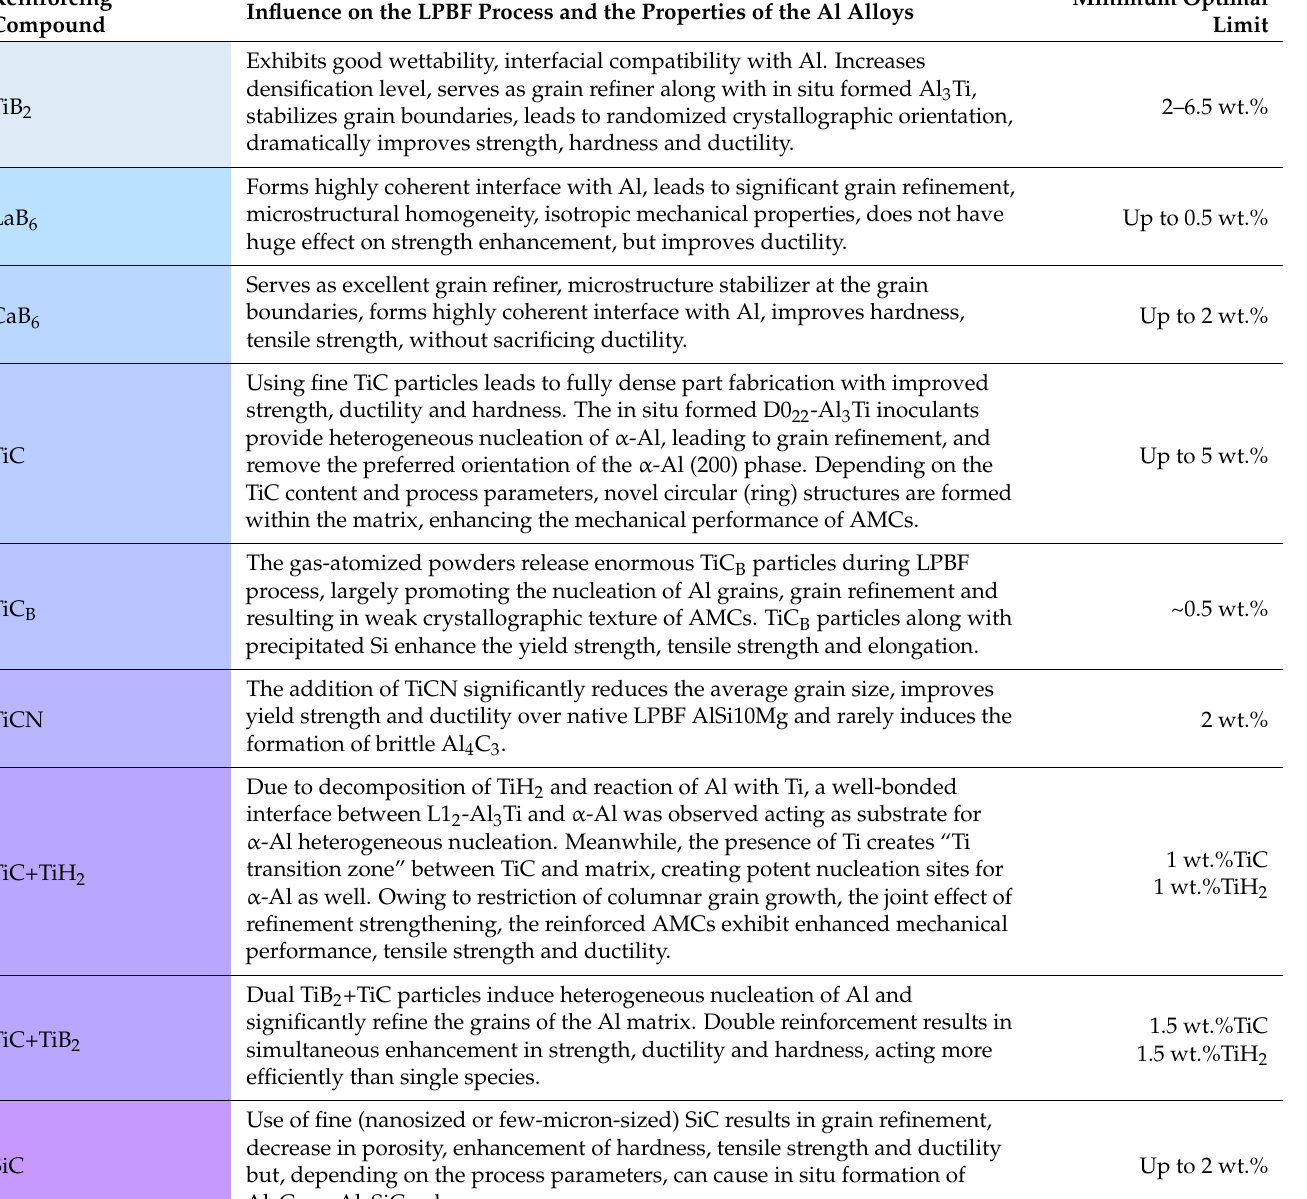
Table 4. The effect of reinforcing compounds on the fabrication and properties of AMCs and their optimal content